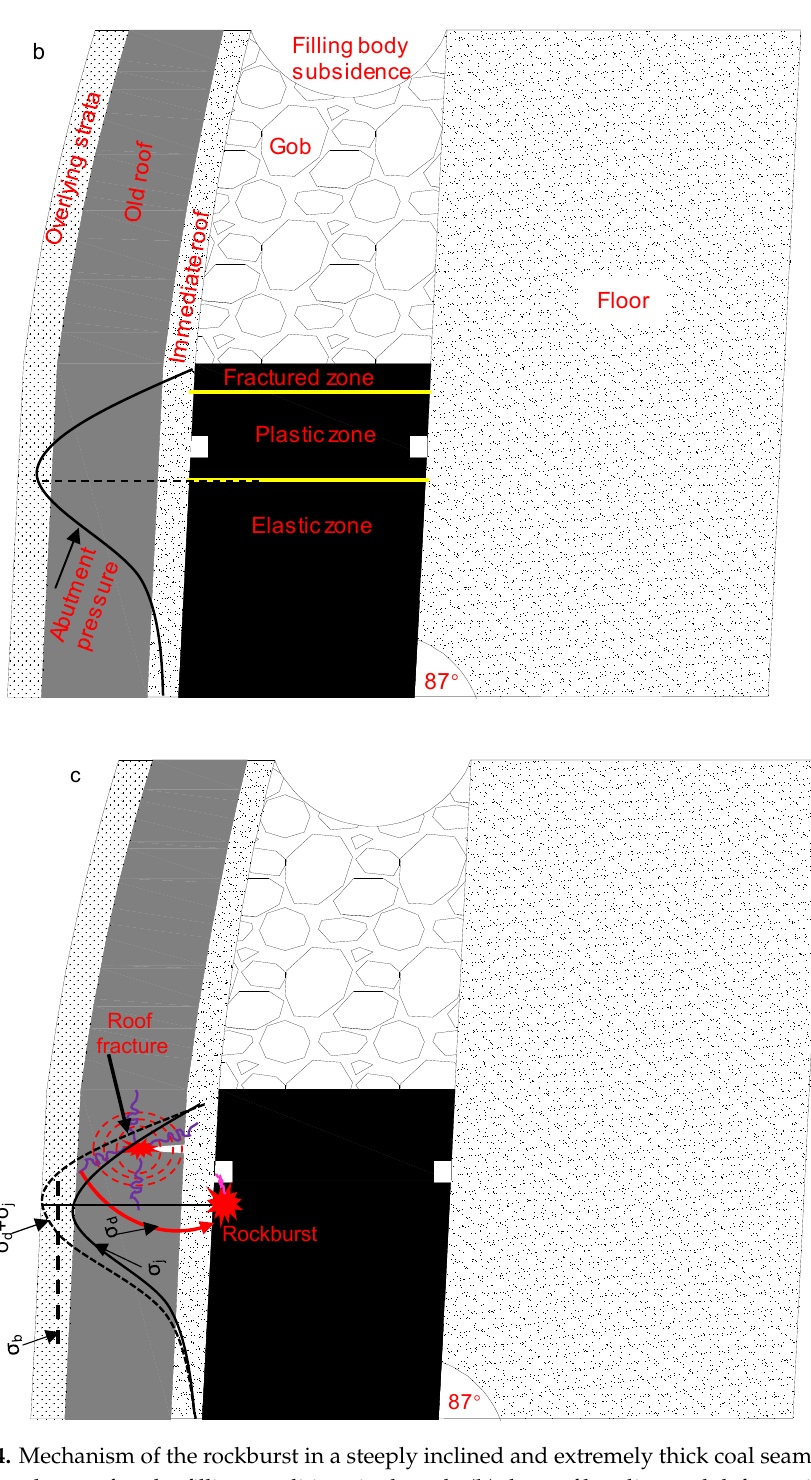
Figure 14. Mechanism of the rockburst in a steeply inclined and extremely thick coal seam (SIETCS): ( a ) the complete roof under filling conditions in the gob, ( b ) the roof bending and deformation caused by the subsidence of the gob filling and ( c ) the dynamic (induced by bending and breaking of the roof) and static combined loads inducing the rockburst.